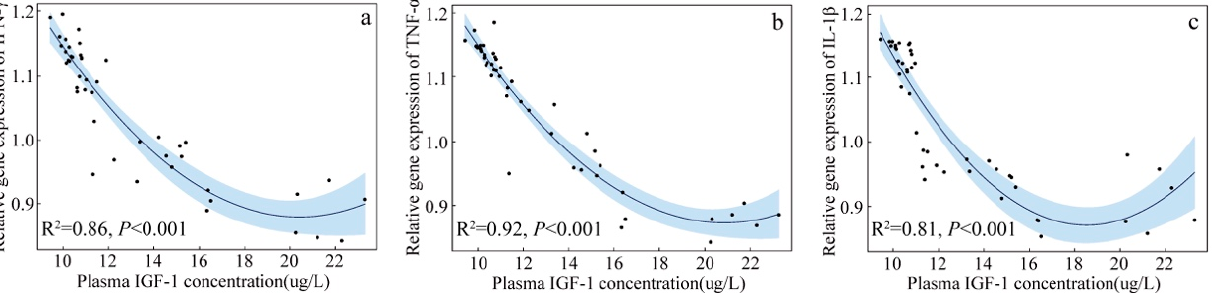
Figure 6. The relationship between plasma IGF-1 concentration and relative expression of the interferon- γ (IFN- γ ) ( a ), tumor necrosis factor- α (TNF- α ), ( b ) interleukin-1 β (IL-1 β ), ( c ) genes of Asian short-toed lark ( Alaudala cheleensis ) nestlings ( n = 45). The blue area is the confidence interval.